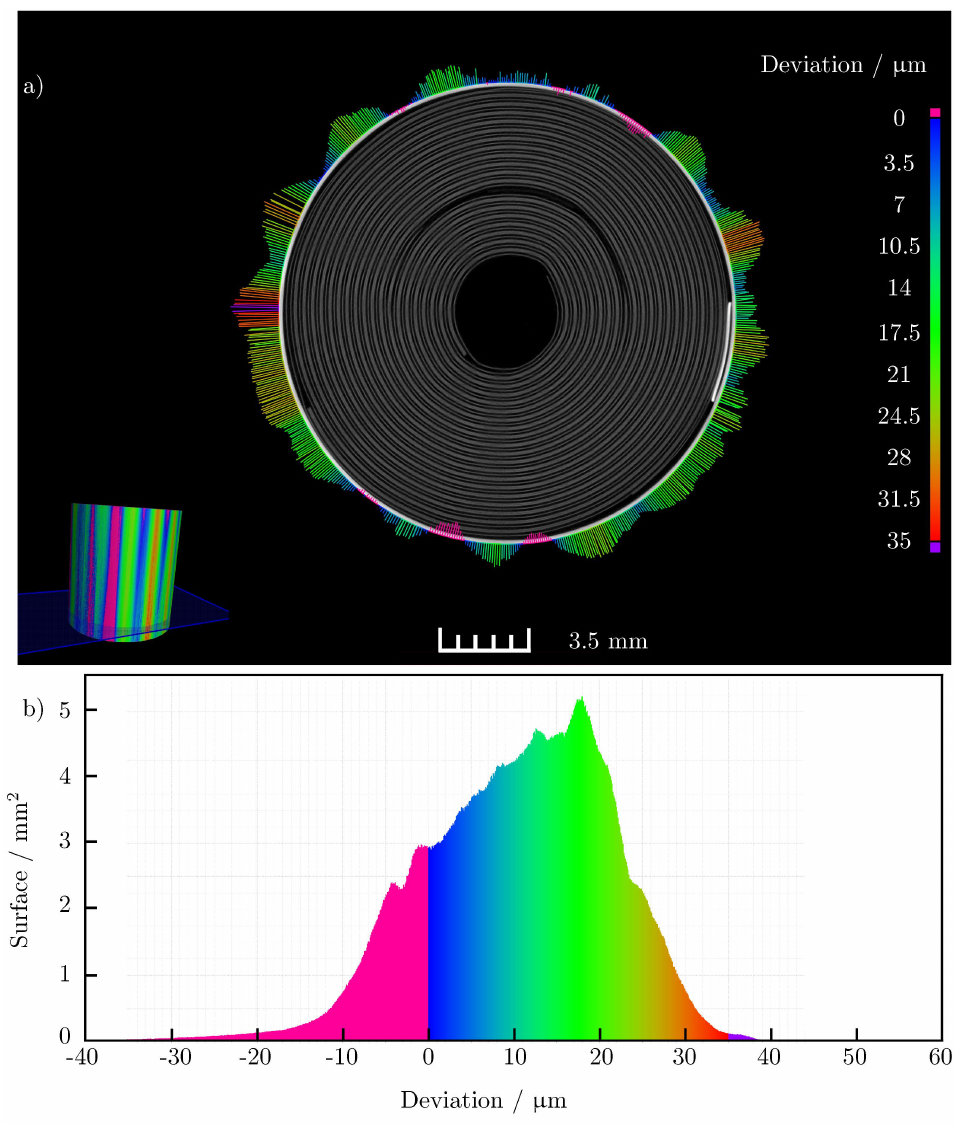
Figure 8. ( a ) Cross − section of the 3D CT image of the battery cell with magnified extent. Contraction of the battery cell is colored in pink; ( b ) representation of the absolute surface of the recorded battery volume, which changes over the charge according to the indicated expansion. The largest proportion of the battery surface expands between 10 µ m and 20 µ m while